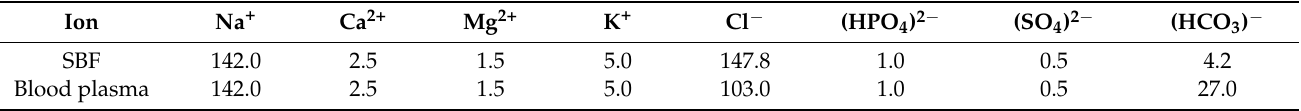
Table 3. The ionic concentration (Mmol/L) of the simulated body fluid (SBF) solution vs. human blood